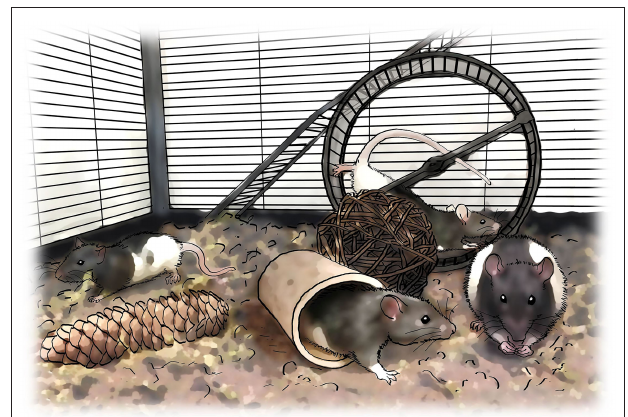
FIGURE 3 | Enriched environment rehabilitation. An alternative to task-specific rehabilitation is to engage the animals in an enriched environment in which they have the chance to voluntarily run along rungs, climb the cage walls, nest with the cage sawdust, manipulate food and run in a running